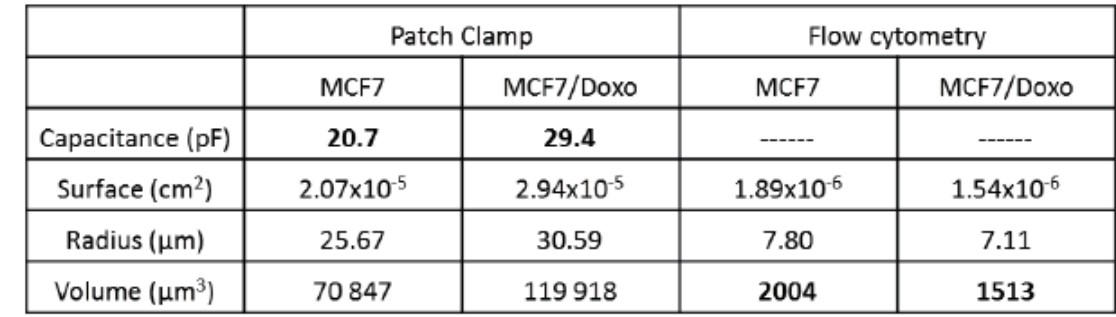
Figure 1. MCF7 and MCF7/Doxo display different morphological features. ( A ) Spatial organization of MCF7 and MCF7/Doxo in phase contrast microscopy. Scale bar: 50 µm; ( B ) Hoffman modulation contrast ( top ) and phase contrast micrographs ( bottom ) of MCF-7 and MCF-7/Doxo in co-cultures. Dishes were seeded with a 50:50 mixture of MCF-7:MCF7/Doxo at day zero. Morphological differences permit an immediate identification of each cell subpopulation islets. MCF7 appeared birefringent and round (rounds) whereas MCF-7/Doxo are more flat and spread (square). Scale bar: 20 µm; ( C ) Cell volume of MCF7 and MCF7/Doxo in flow cytometry. The electronic volume (EV) was determined by the flow cytometer according to the Coulter Principle; ( D ) Histograms giving the mean cell diameter ( left ) and volume ( right ) for 185 repeated experiments. The MCF7 appear significantly bigger than the MCF7/Doxo. Data are presented as mean ± SEM; ( E ) Whole-cell capacitance measurements of MCF7 and MCF7/Doxo. MCF7/Doxo display a higher whole-cell capacitance than the MCF7. Data are presented as mean ± SEM; ( F ) Summary of the different size measured or calculated for the MCF7 and MCF7/Doxo. *** p < 0.001